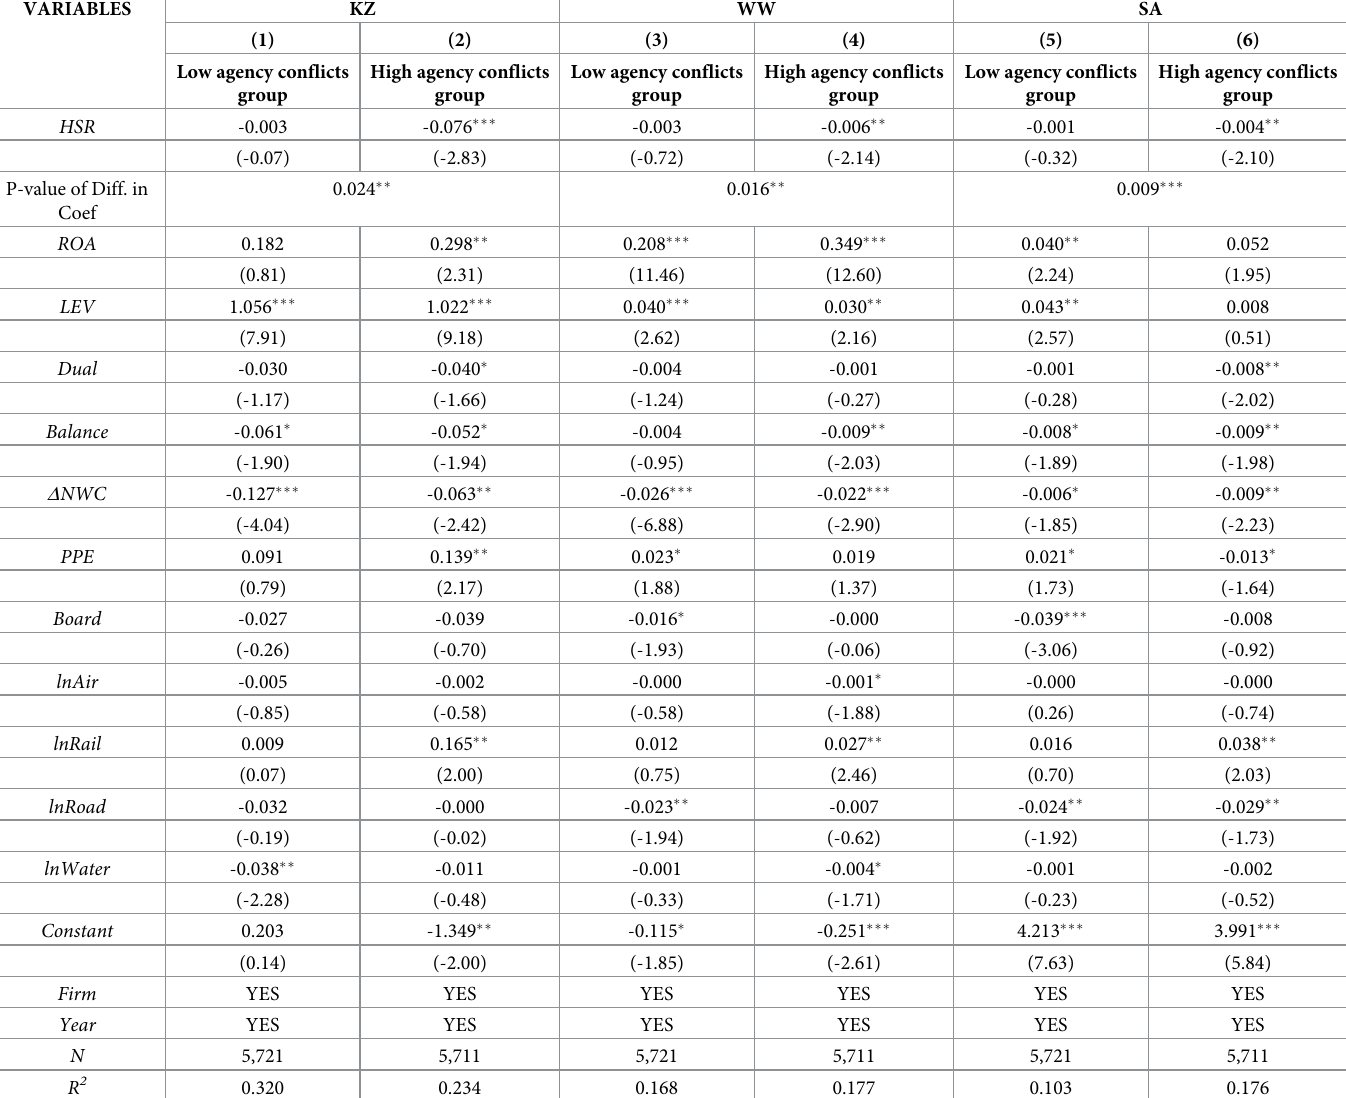
Table 13. Test results of the first type of agency problem